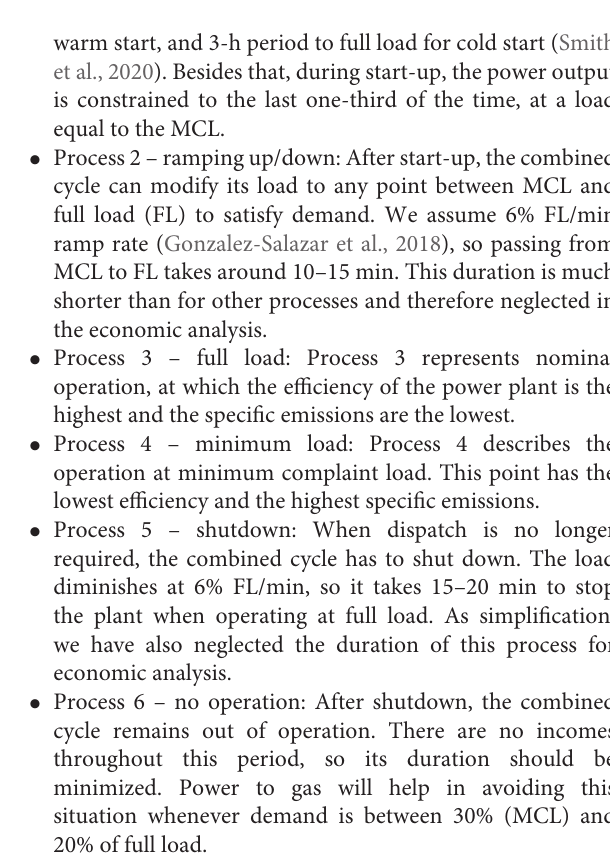
is to compare and quantify this proposal with different scenarios of shutdowns and conventional